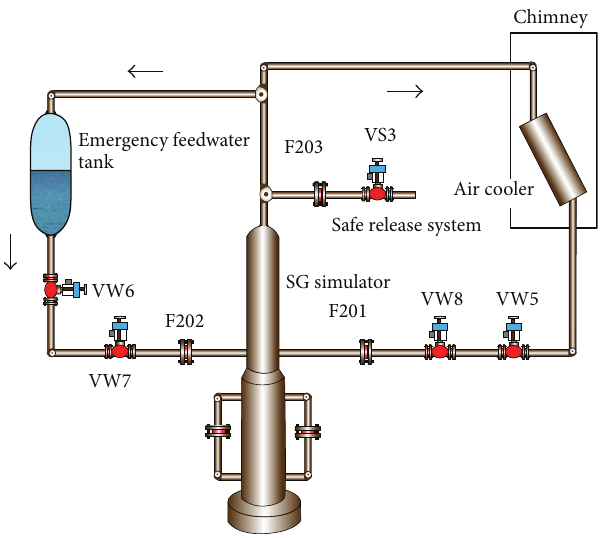
Figure 1: Schematic diagram of PRHRS test facility.